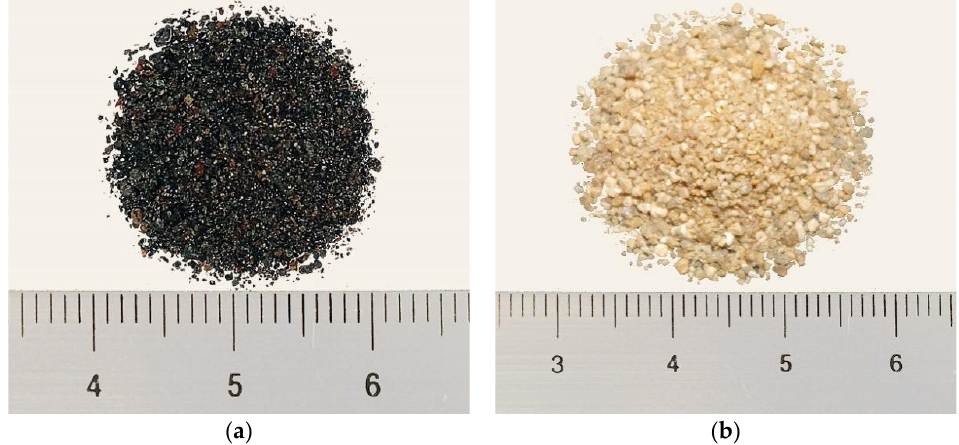
Figure 1. Photograph of fine aggregates used. ( a ) Magnetite fine aggregate. ( b ) River sands.